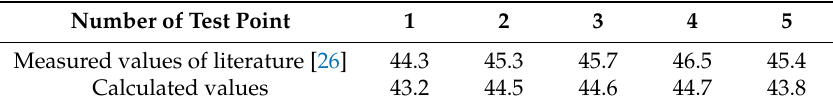
Figure 5. Distribution of test points. Table 2. Comparison of magnetic pole temperature data (Unit ◦ C).